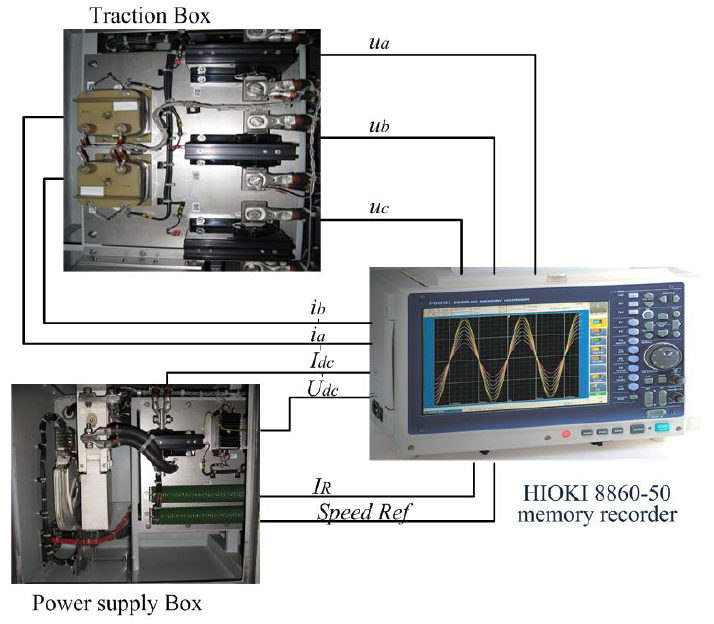
Figure 6. Schematic diagram of the electrical data